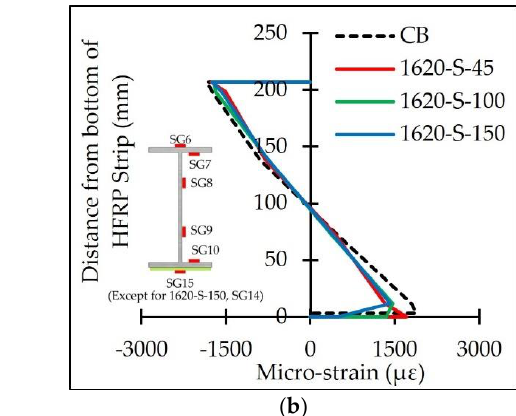
Figure 24. Strain distribution along the HFRP strips of 1620-S-45, 1620-S-100 and 1620-S-150 at 380 kN. 3.3.3. Effect of HFRP Length Assessing the impact of HFRP length on the performance is presented by comparing the strain variations in 1620-S-100, 1170-S-100 and 810-S-100 specimens in which HFRP thickness and spacing between bolts are kept unchanged. The strain profiles at the mid- segment and edge-segment of the three specimens and CB at 310 kN are depicted in Figure 25a,b, respectively. Better composite action can be observed in 1620-S-100 compared to 1170-S-100 and 810-S-100. The slippage at the steel-HFRP interface in the mid-segment of 810-S-100 was triple that of the 1170-S-100 specimen, which highlights the significant ef- fect of HFRP length, and consequently the number of fastening bolts, on the composite section. It can be noticed from Figure 25 that the effectiveness of the fastened HFRP strips in reducing the steel tensile strains was more pronounced in the mid-segment than in the edge-segment. This could be attributed to the combined shear – flexure effect in the edge- segment, as opposed to the pure flexural effect in the mid-segment.